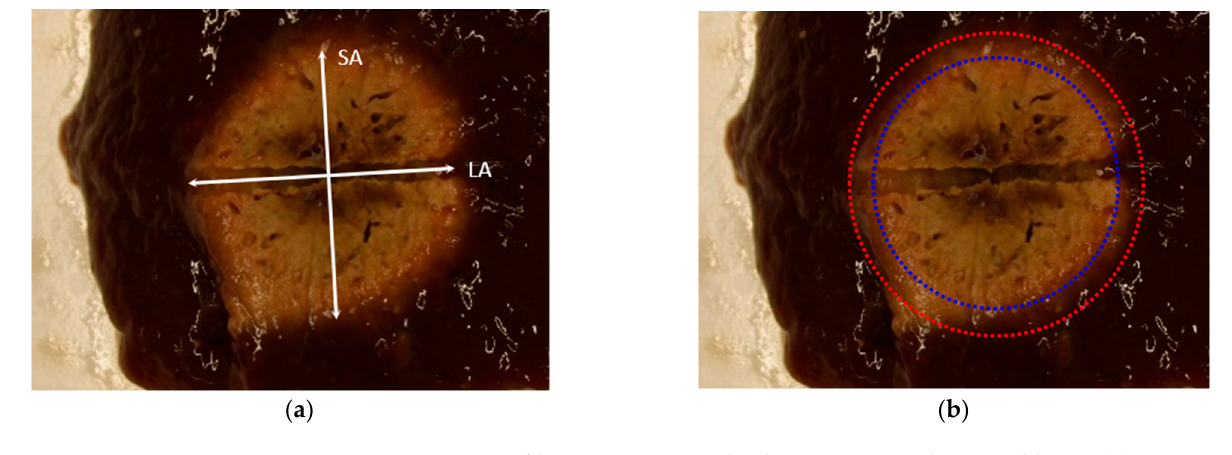
Figure 1. Assessment of lesion zone size within liver tissue samples post-ablation. ( a ) Determination of short axis (SA) and long axis (LA) and ( b ) and differentiation of the inner (blue) and outer (red) ablation zone.